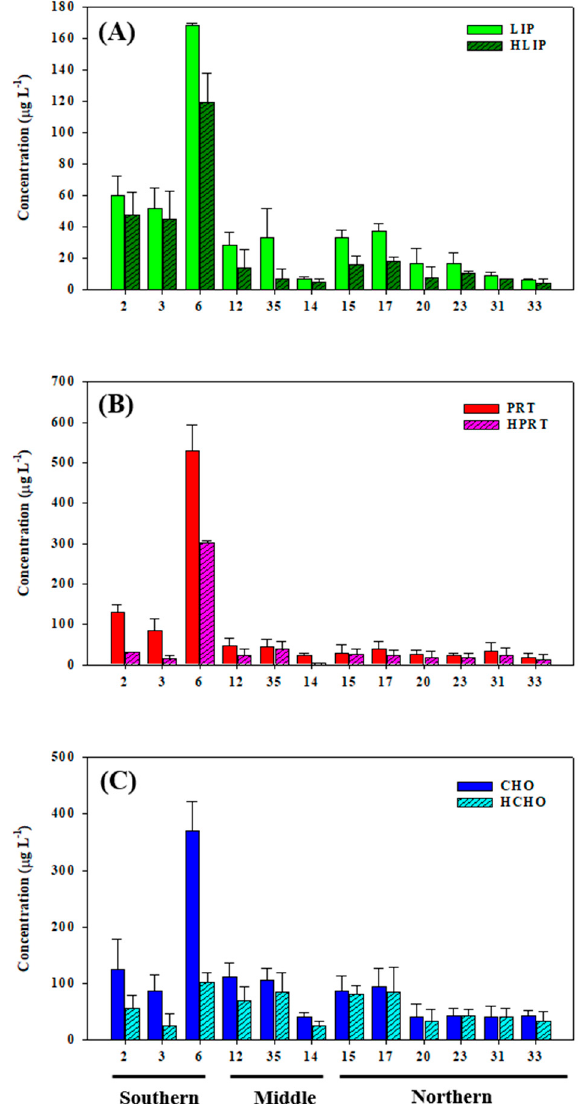
Figure 4. Average total ( n = 51) and hydrolysable ( n = 35) ( A ) lipids, ( B ) proteins, and ( C ) carbohydrates concentration of particulate organic matter (POM) within euphotic layer. Error bar indicated standard deviation ( n = 2–6).